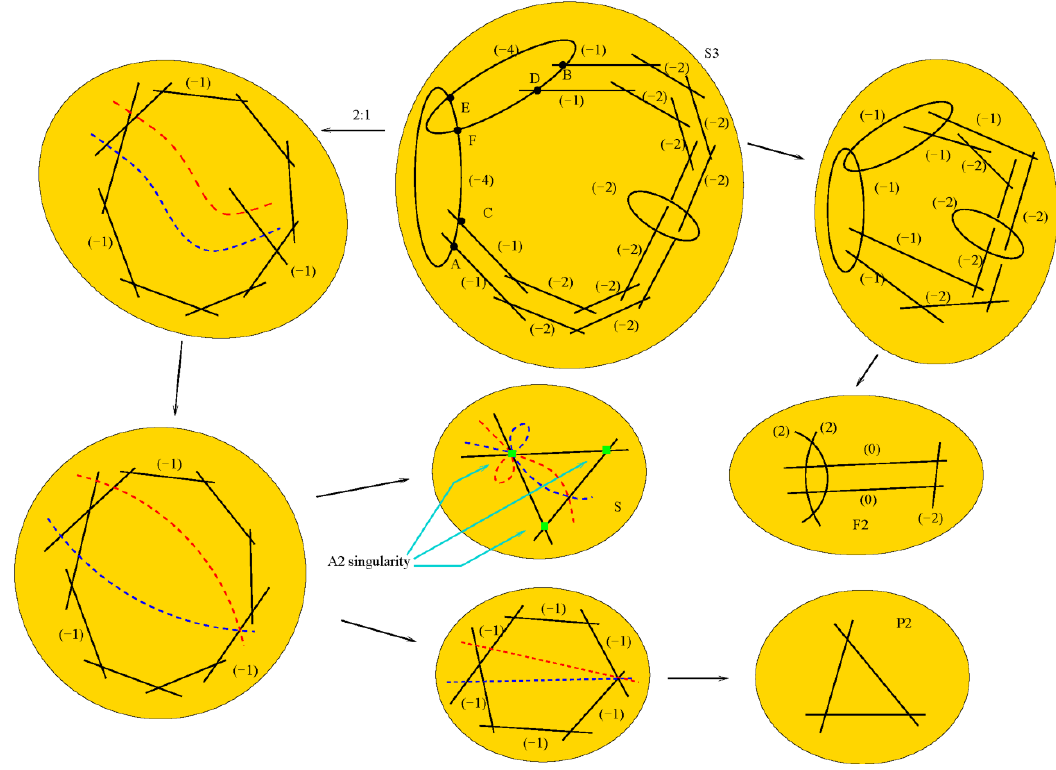
and H after flops in the exceptional curves on e S 1 2